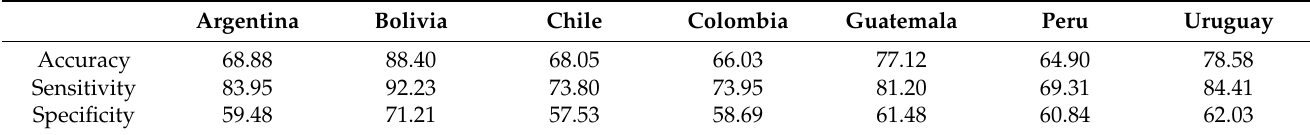
Table 6. Confusion matrix stage 3 CDM model, process innovation.